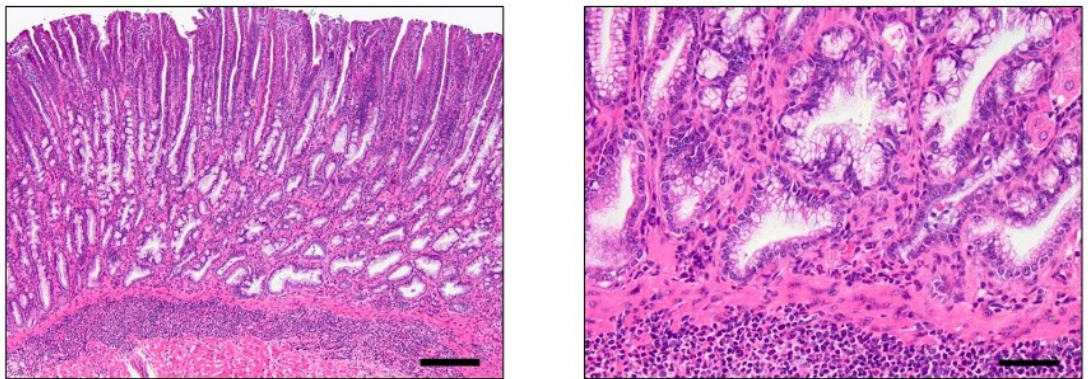
Figure 3. H/K-ATPase-IL-1β mouse: Inflammation, Metaplasia and Dysplasia. Low and high magnification images of the gastric corpus depicting prominent mucosal and submucosal granulocytic and lymphocytic inflammation with oxyntic loss, mucous metaplasia, foveolar and glandular hyperplasia, as well as dysplasia characterized by glandular architectural abnormalities such as misorientation, splitting, elongation, back to back formation, crowding and mild cellular atypia. (Bar: Left 100× or 160 μM, Right 400× or 40